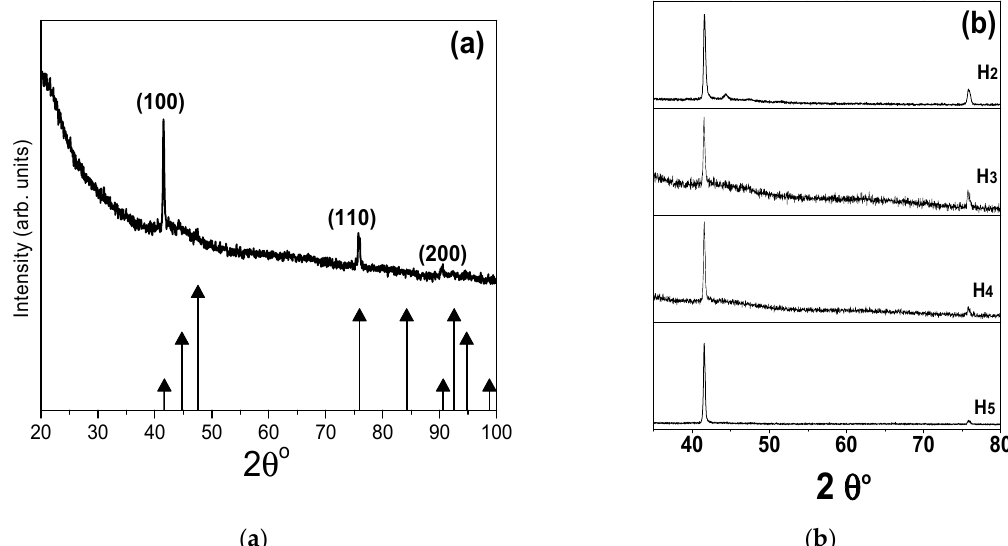
Figure 3. XRD micrographs of sample H1 ( a ) and all other samples (H2, H3, H4, and H5) used in this study ( b ), along with standard hcp cobalt XRD pattern.